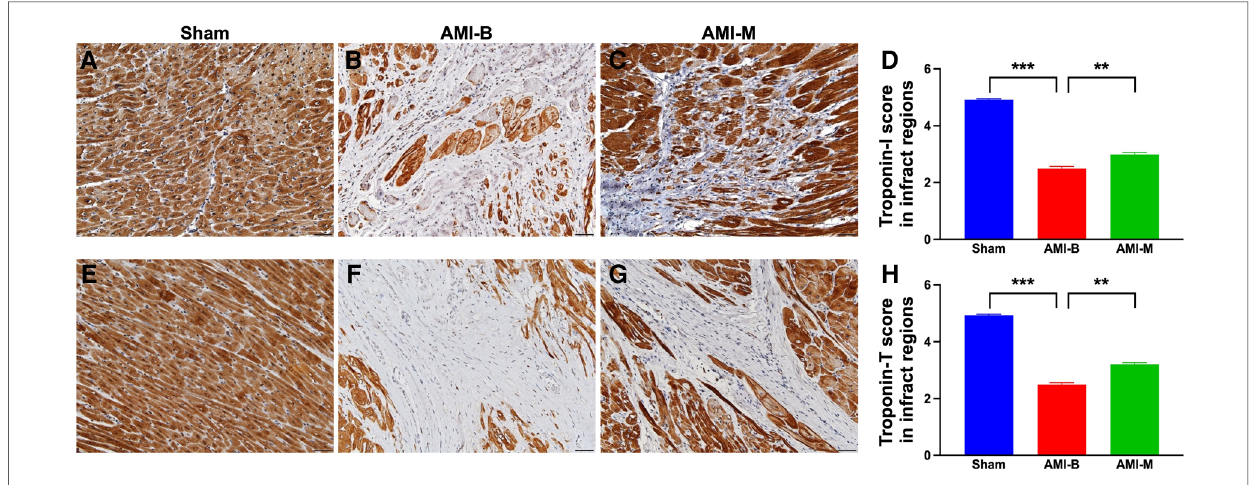
FIGURE 5 Immunohistochemical staining for identi fi cation of troponin-I and troponin-T expressions of LV infarct myocardium by 5 months after AMI induction. ( A – C ) The microscopic fi nding (200×) of IHC stain for identi fi cation of the cellular expression of troponin-I (gray color). ( D ) Analytical result of the expression of IHC-stained intensity score of troponin-I; *** p <0.0001; ** p <0.001. ( E – G ) The microscopic fi nding (200×) of IHC stain for identi fi cation of the cellular expression of troponin-T (gray color). ( H ) Analytical result of the expression of IHC-stained intensity score of troponin-T; *** p <0.0001; ** p <0.001. All scale bars in lower right corner represent 50 µm. Sham (group 1), sham-operated control; AMI-B (group 2), AMI+ buffer; AMI-M (group 3), AMI+hBMMSC; AMI, acute myocardial infarction; hBMMSCs, human bone marrow-derived mesenchymal stem cells; LV, left ventricular; IHC, immunohistochemical.